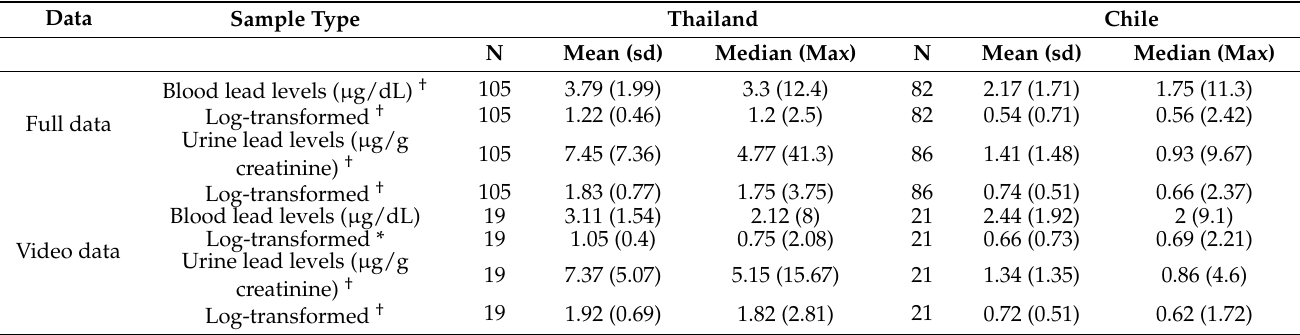
Table 2. Urine and blood lead concentrations among Thai and Chilean e-waste recycling workers across all (full data) and video participants (video